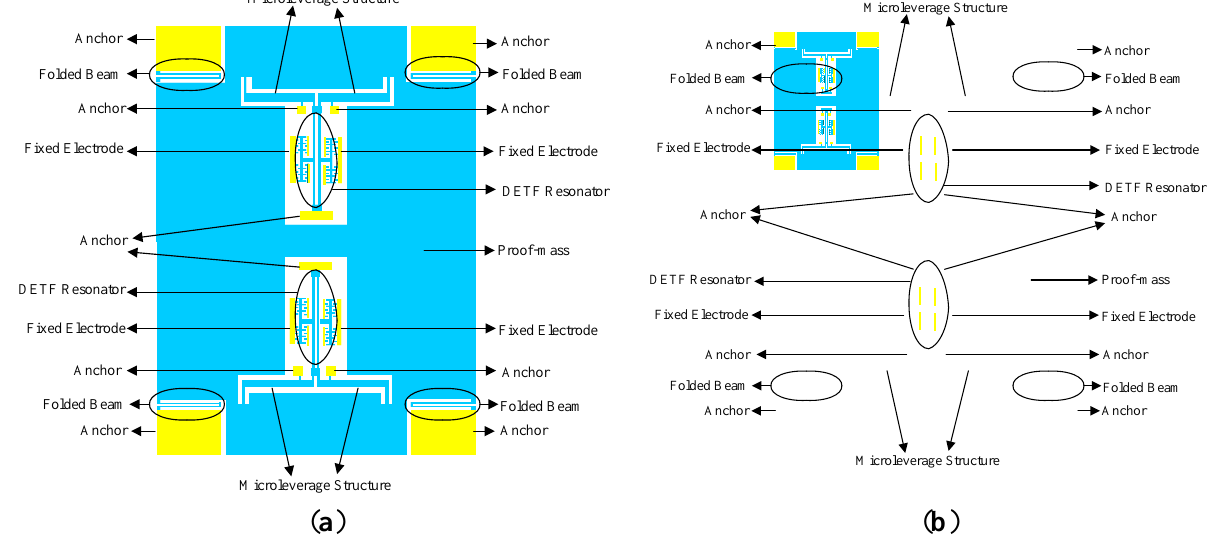
Figure 6. ( a ) The diagram of the accelerometer equipped with the common DETF structure; ( b ) The diagram of the accelerometer equipped with the improved DETF